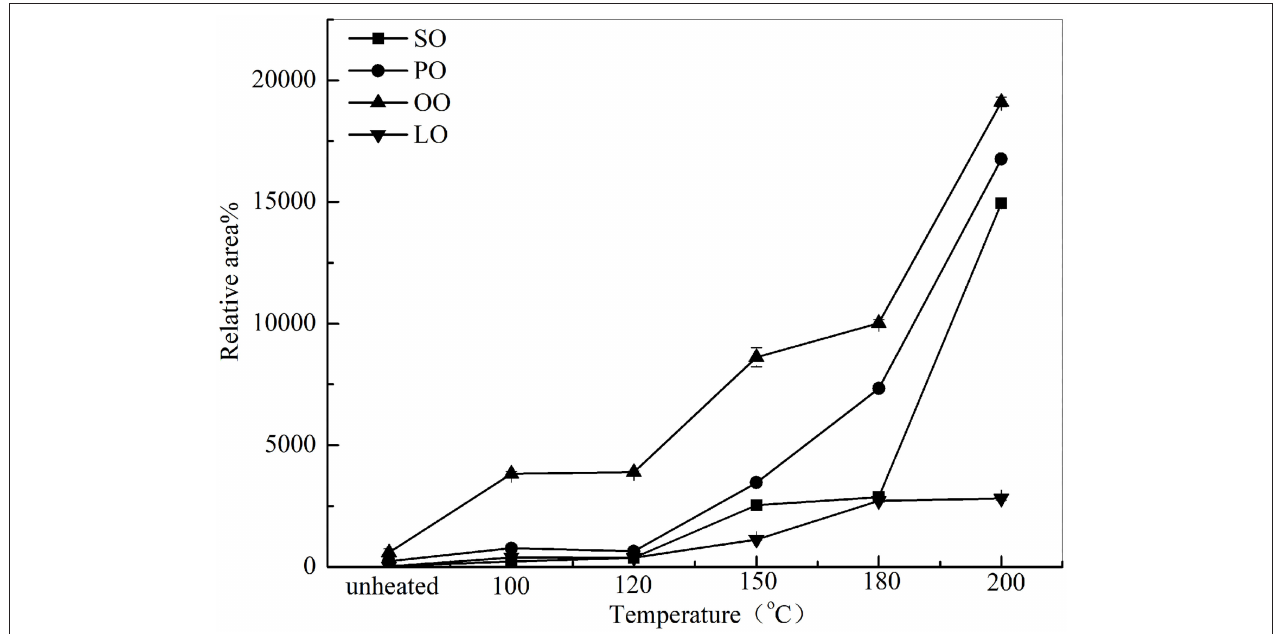
FIGURE 3 | Changes of total volatile compounds in SO, PO, OO, and LO at different temperatures. Data were expressed as mean ± SD in triplicates.